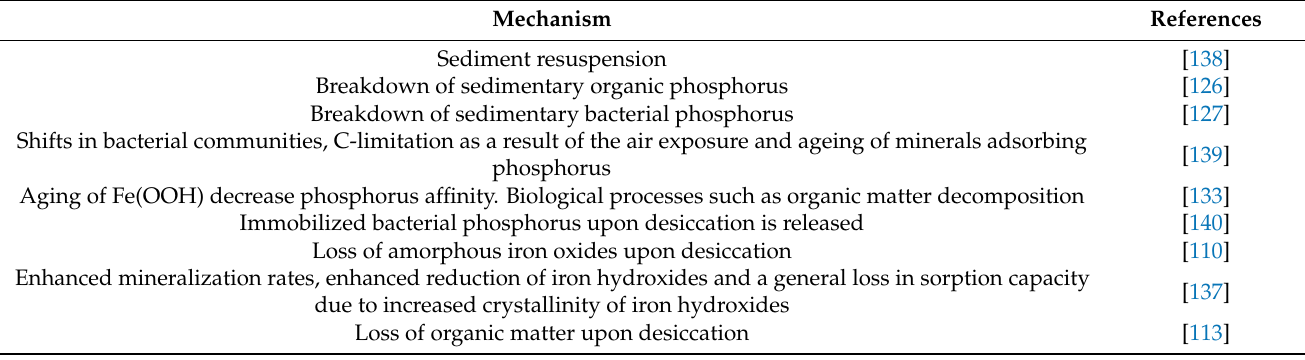
Table 2. Mechanisms responsible for phosphorus release upon re-flooding of dry sediment reported by the literature in inland aquatic